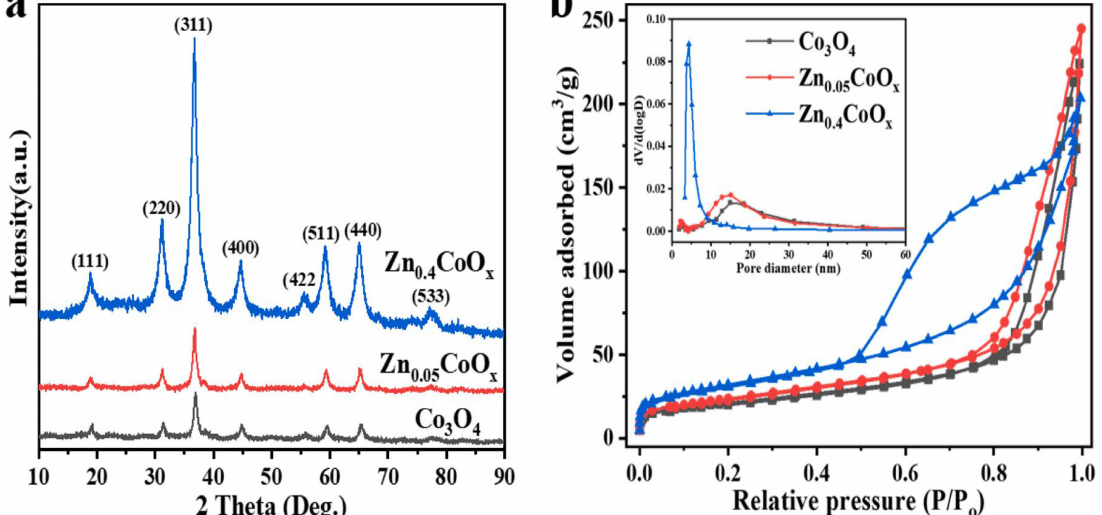
Figure 4. ( a ) XRD patterns and ( b ) nitrogen adsorption-desorption isotherms and the corresponding pore size distributions (inset) of Co 3 O 4 , Zn 0.05 CoO x , and Zn 0.4 CoO x . Reproduced with permission from Ref. [106]. Copyright 2022 Yunlong